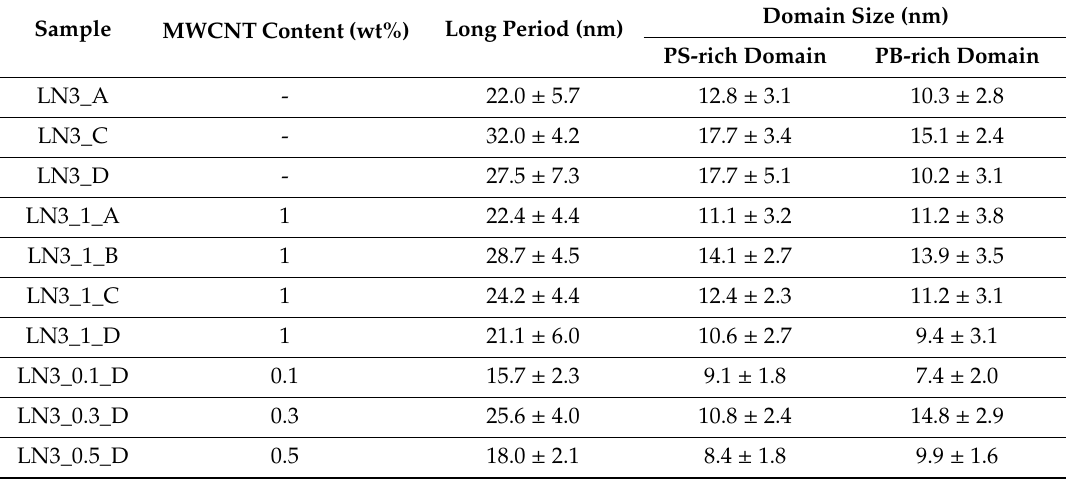
Table 3. Long period and domain sizes of the lamellar morphologies of LN3 and LN3 / MWCNT composites evaluated from TEM images.